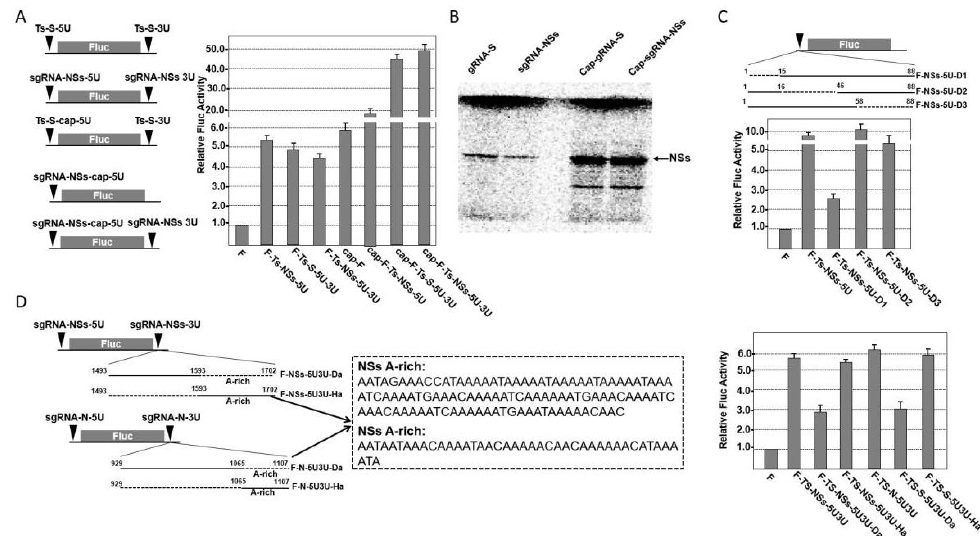
Figure 4. Translational characteristics of TSWV RNA S and sgRNA-NS s. ( A ) Effect of 5′ and 3′ UTR of TSWV RNA S and sgRNA-NSs on in vitro translation of the reporter gene with or without 5′ cap. ( B ) In vitro translation of S RNA and sgRNA-NS s in WGE. ( C ) Effects of deletion mutations of sgRNA- NSs 5′ UTR on the translation of the reporter gene. ( D ) Effects of deletion mutations of sgRNA-NSs 3′ UTR on the translation of the reporter gene.